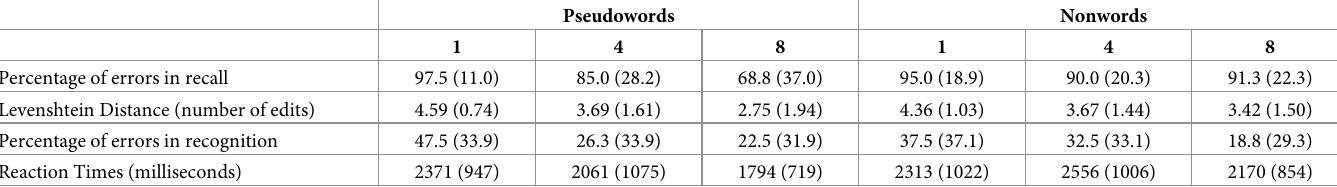
Table 2. Descriptive statistics for each of the dependent variables in each of the conditions tested in the recall and recognition tests.